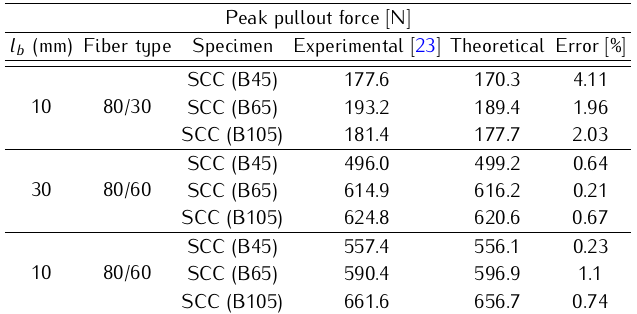
Table 7. Comparison of experimental peak pullout force (Grünewald [27]) versus predicted peak pullout force by using proposed model.